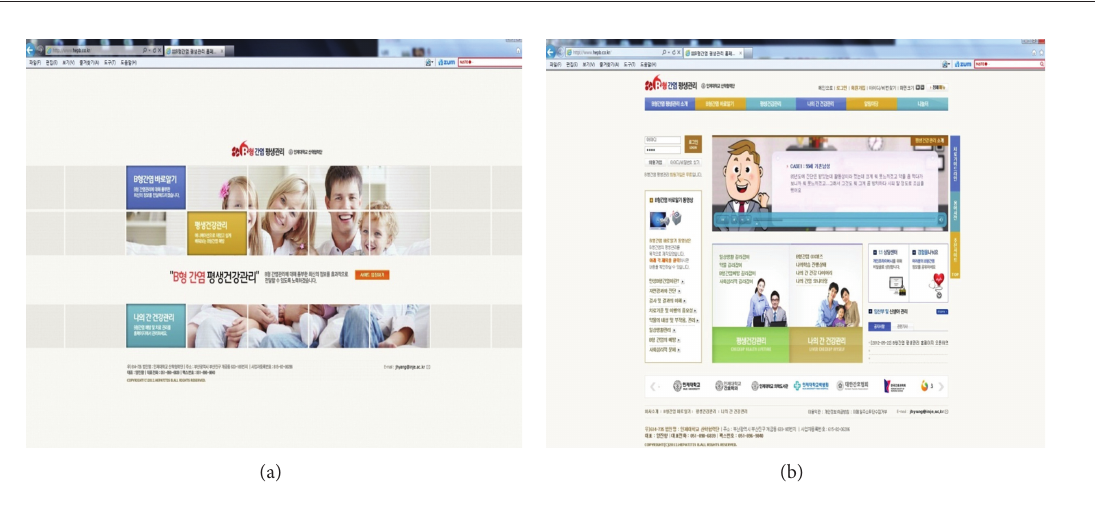
F 2: Initial screen and main